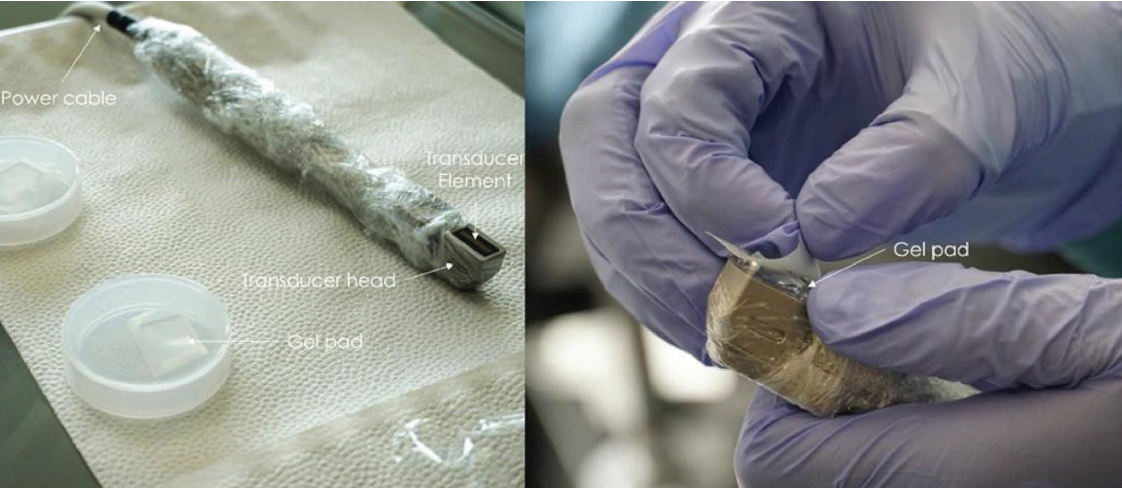
Figure 1: Transducer and gel pad.